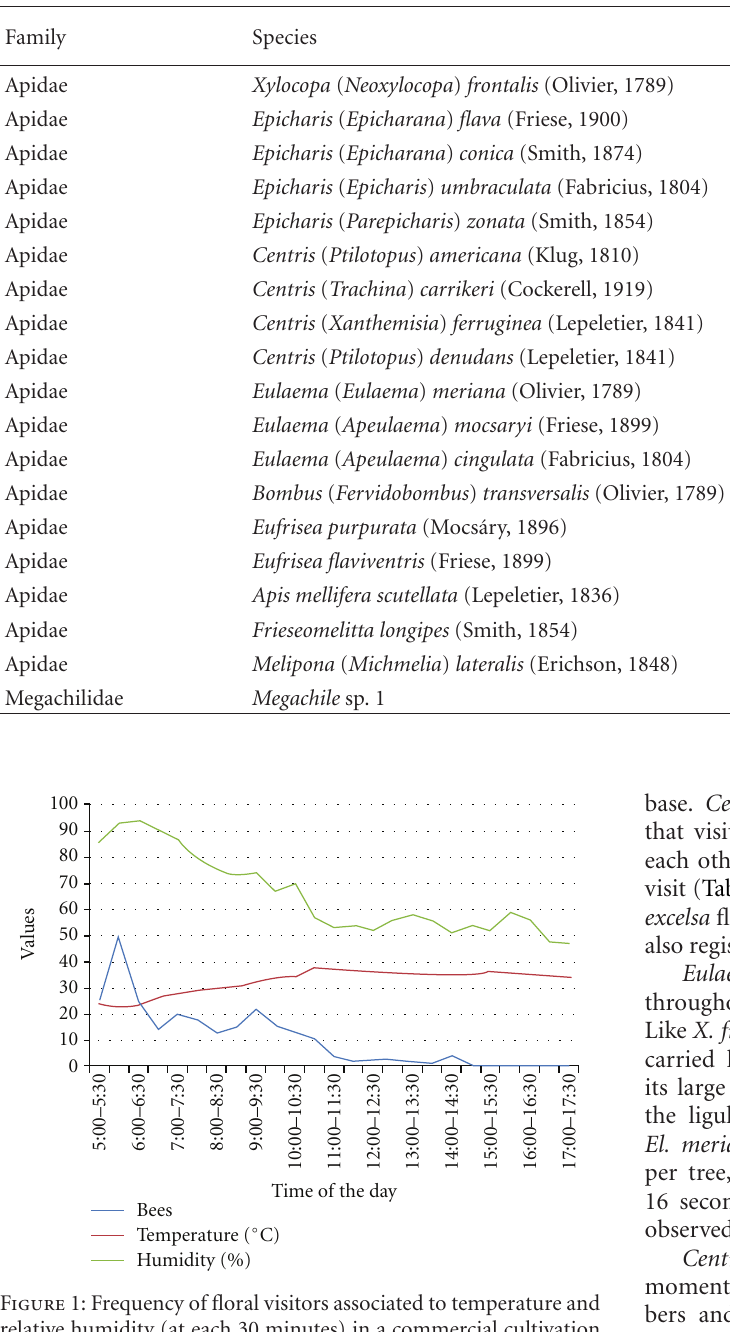
Table 2: List of families, species, sex and body size of bees, floral visitors, and potential pollinators of Brazil nut ( Bertholletia excelsa ), collected in a commercial cultivation in the county of Itacoatiara, state of Amazonas, Brazil, 2007.